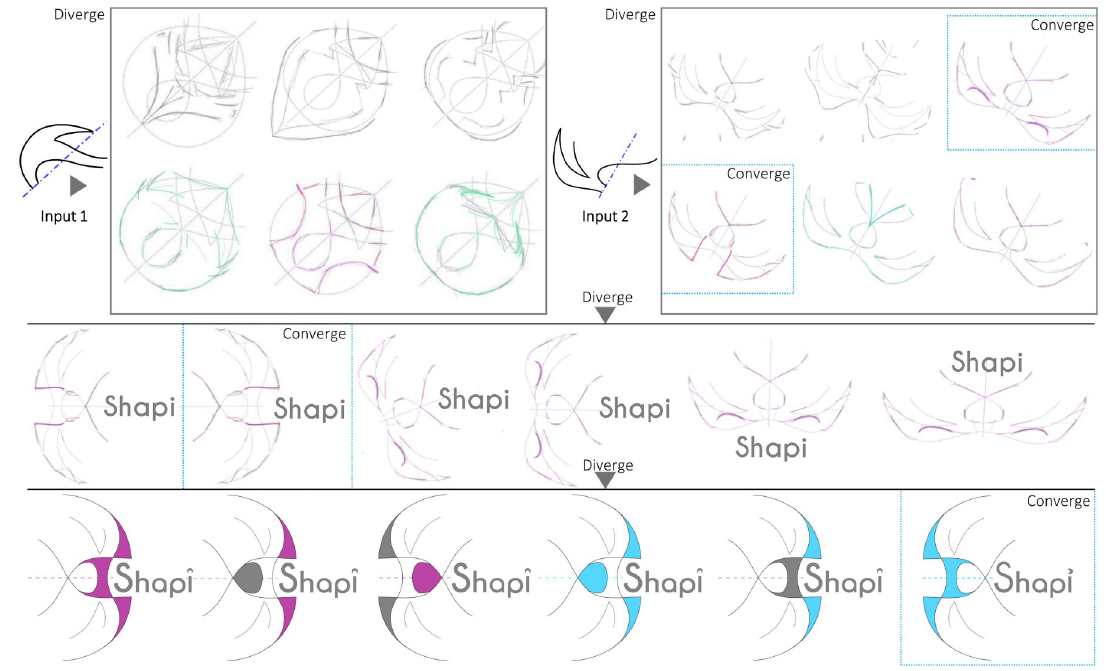
Fig 16. Two abstract Seeds are explored with Shapi. Several cycles of divergence-convergence result in the Shapi